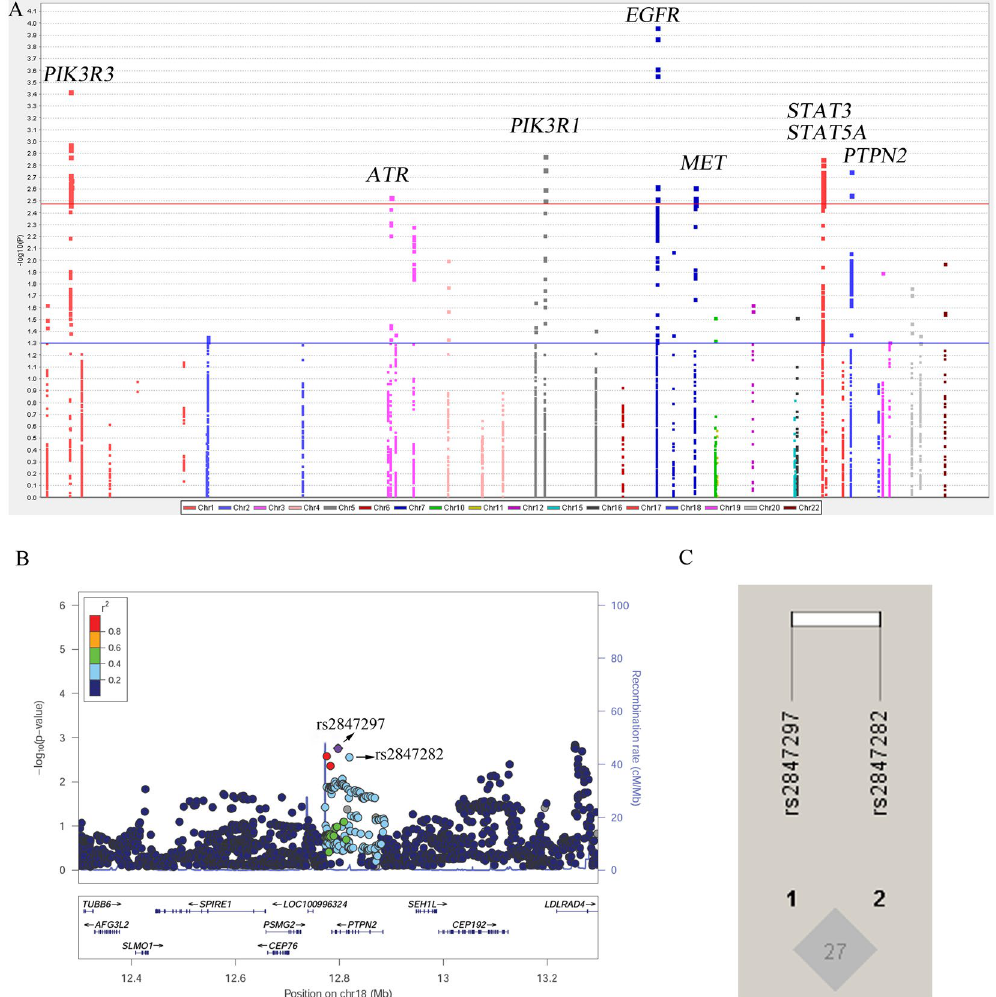
Figure 1. Screening of SNPs in the TCPTP pathway. ( A ) Manhattan plot of genome-wide association results of 5,162 SNPs in 43 TCPTP pathway genes and lung cancer risk in the TRICL-ILCCO Consortium. SNPs are plotted on the X-axis according to their positions on each chromosome. The association P values with lung cancer risk are shown on the Y-axis (as − log 10 ( P ) values). The horizontal red line represents FDR threshold 0.20. The horizontal blue line represents P value of 0.05; ( B ) SNPs in PTPN2 with 500 kb up- and downstream of the gene region and ( C ) LD plots of the SNPs in PTPN2 with FDR < 0.20. In B , the left-hand y-axis shows the association P value of each SNP, which is plotted as − log 10 ( P ) against chromosomal base pair position; the right-hand y-axis shows the recombination rate estimated from the hg19/1000 Genomes European